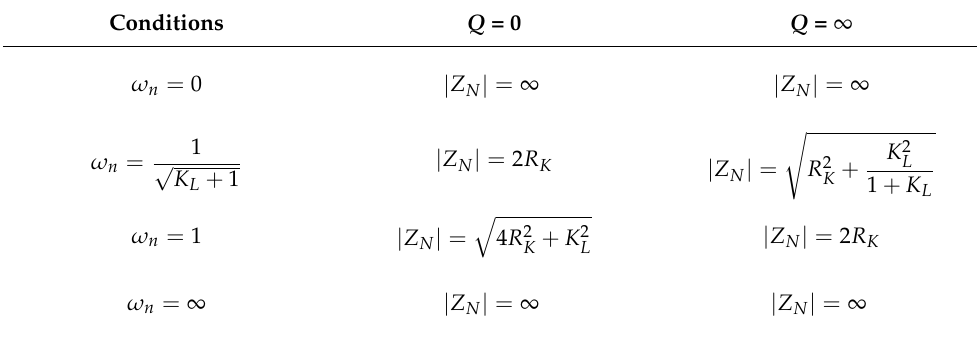
Table 2. Normalized input impedance Z N of the converter, according to each normalized fre- quency ω n